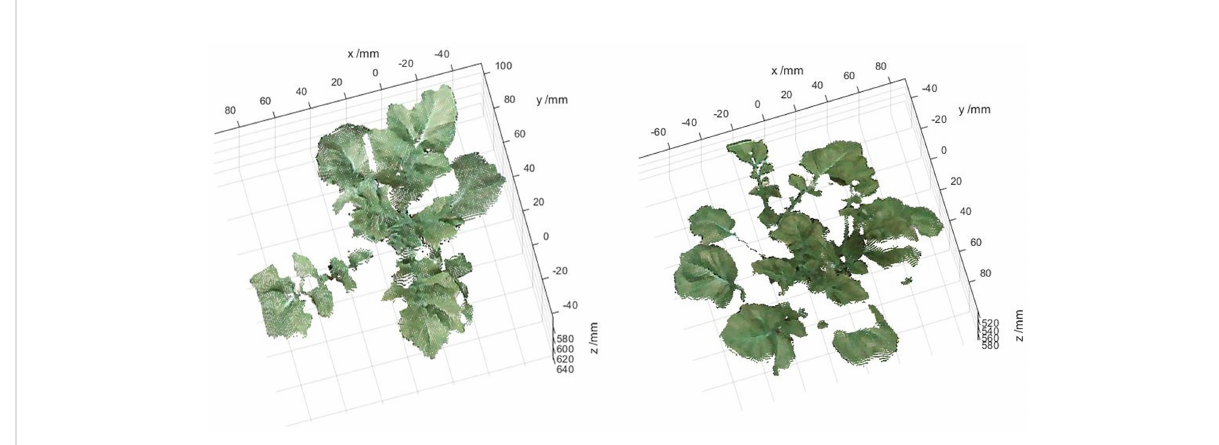
FIGURE 10 Two examples of the optimized PCD of potato plant. (unit: